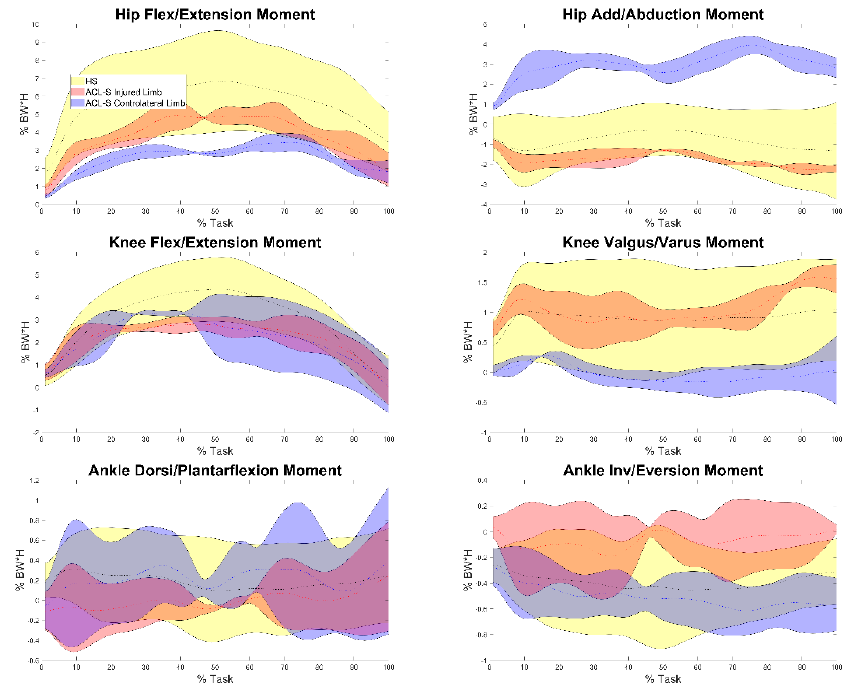
Figure A3. Hip, knee and ankle adduction/abduction and flexion/extension moments, calculated through the ACL Quick Check ® integrated: HS (yellow), ACL ‐ S injured limb (red) and ACL ‐ S contralateral limb (blue). Average plus and minus one standard deviation are reported as coloured bands.